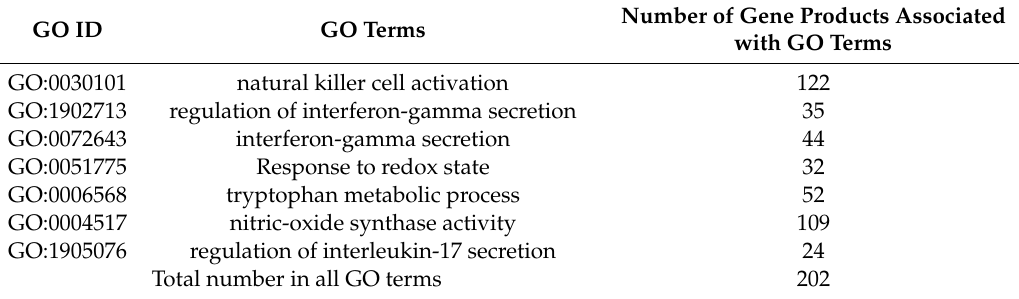
Table 2. Total number of Annotations for GO study of innate immune responses and tick-borne pathogens which might be playing a critical role of NK cell in IFN- γ secretion.